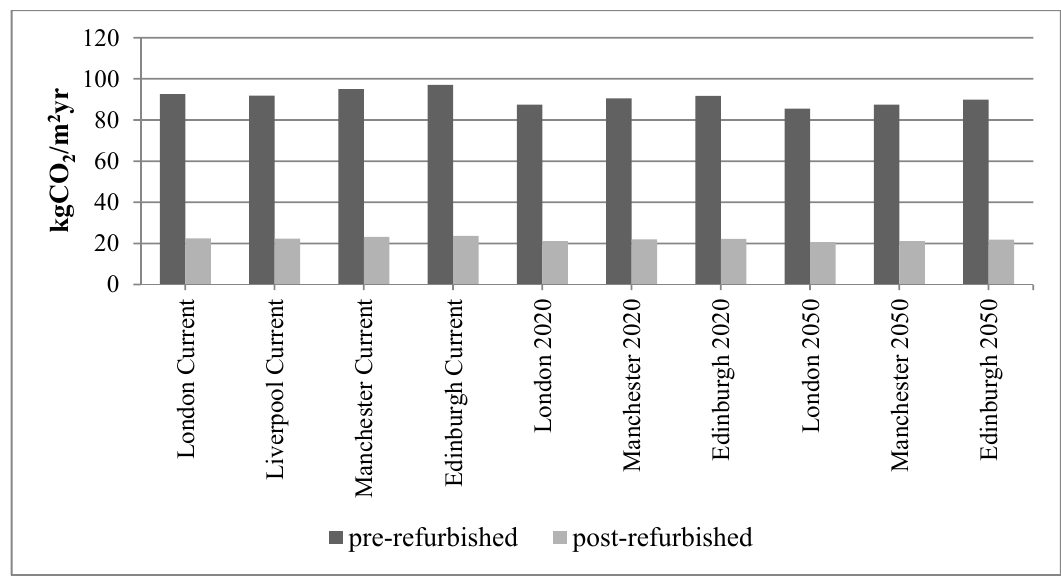
Figure 8. Annual CO emissions (kgCO /m 2 yr) from pre and post-refurbished house in 2 2 different cities under current and future weather conditions.